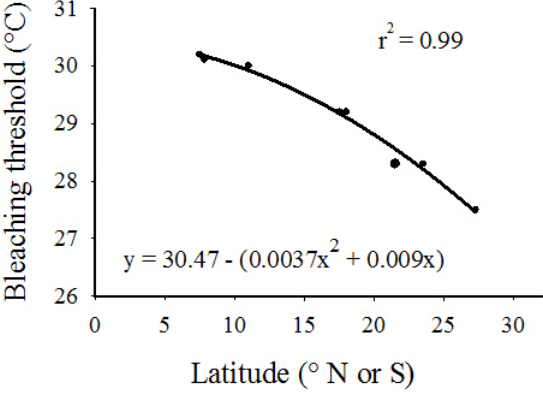
Figure 6. Second-order polynomial plot of thermal bleaching threshold data derived from thermal threshold estimates published in Hoegh-Guldberg [2]—Jamaica, Phuket, Tahiti, Rarotonga, and northern, central and southern GBR, and Cellier and Schleyer [32]—Sodwana Bay, South Africa. Bleaching thermal stress values for regions outside these latitudes may be hypothetically extrapolated using this regression